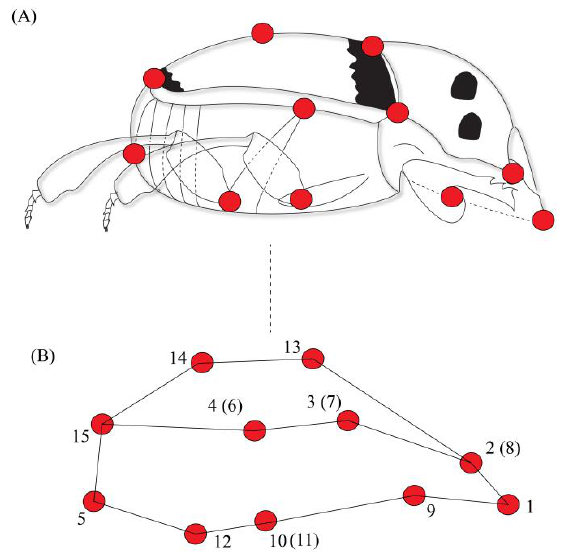
Figure 1. Landmarks (red dots) used in shape analysis of C . quinquemaculatus . ( A ) Lateral view; ( B ) Graphical representation of body shape based on 15 landmarks, adapted from Hernández et al. [8]. Landmarks in parentheses correspond to the same region on the other side of the body.